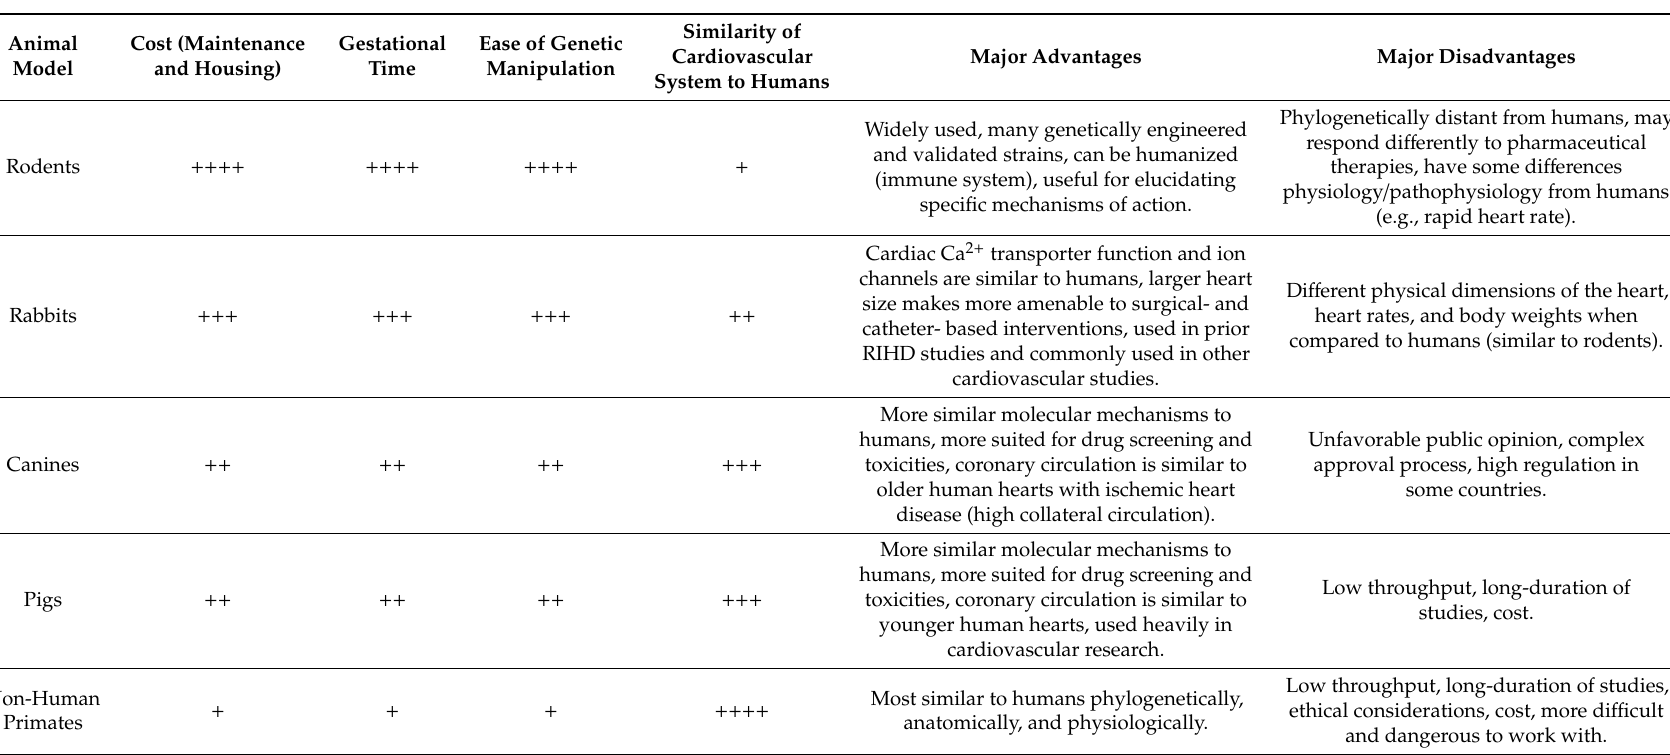
Table 1. Comparison of the main characteristics, advantages, and disadvantages of di ff erent animal species used in the study of RIHD. Items are ranked from highly optimal ( ++++ ) to less optimal ( +